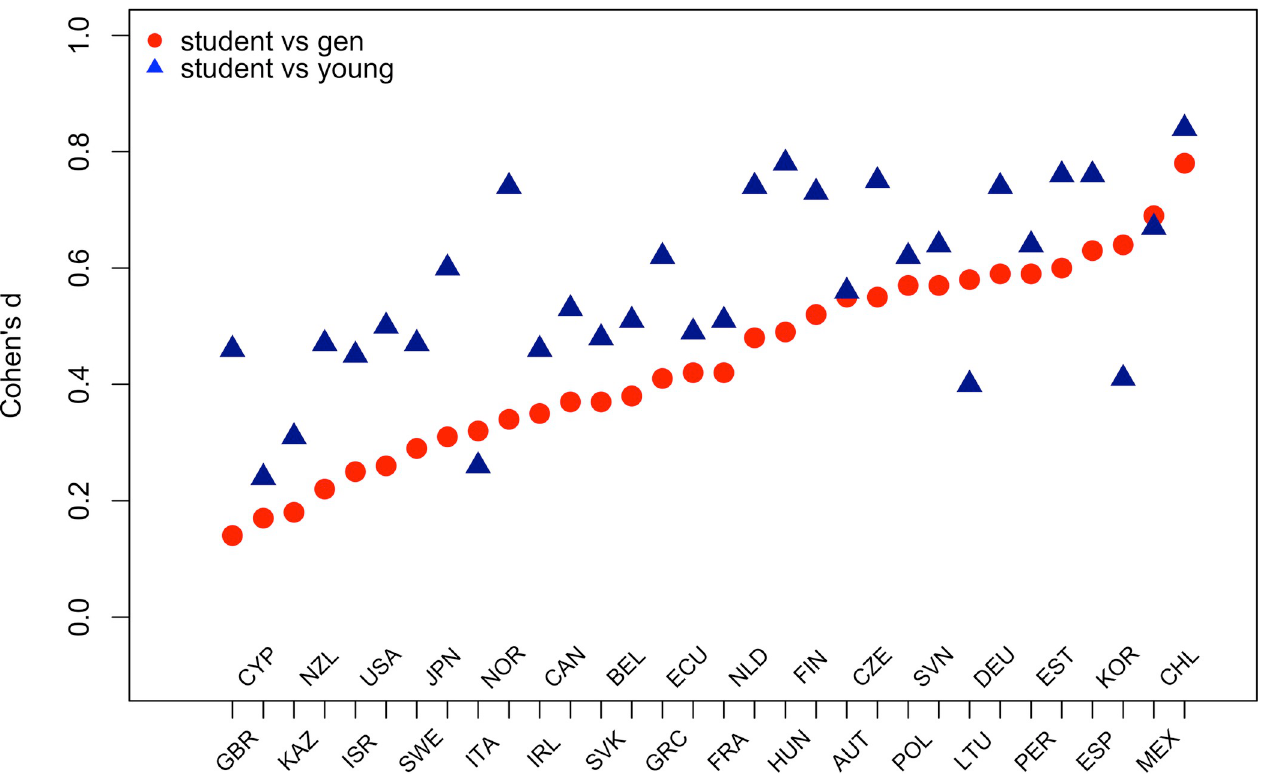
Fig 4. Effect size comparisons in numeracy scores between the Student and General samples and the Student and Young by country. Red dots represent effect size comparison of Student vs General samples and blue triangles represent effect size comparison for Student vs Young samples.